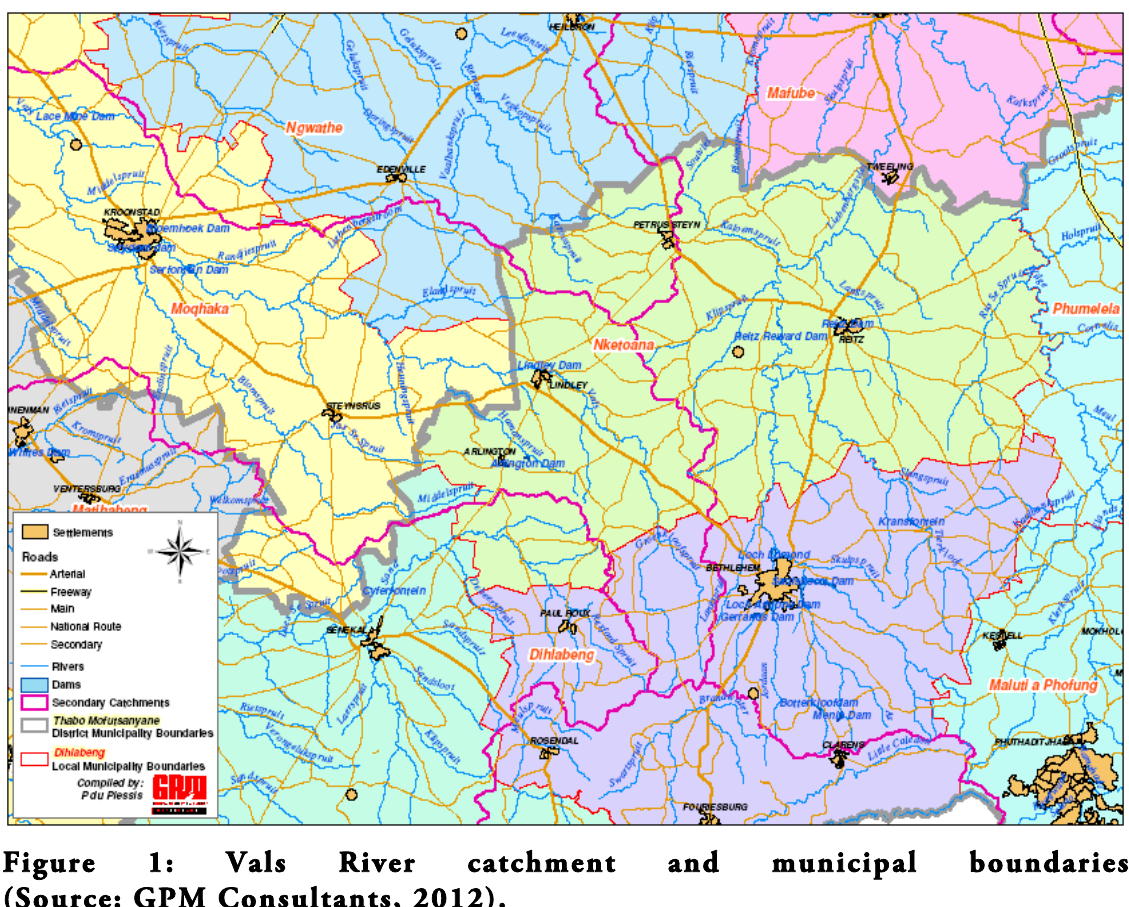
Figure 1: Vals River catchment and municipal boundaries (Source: GPM Consultants,